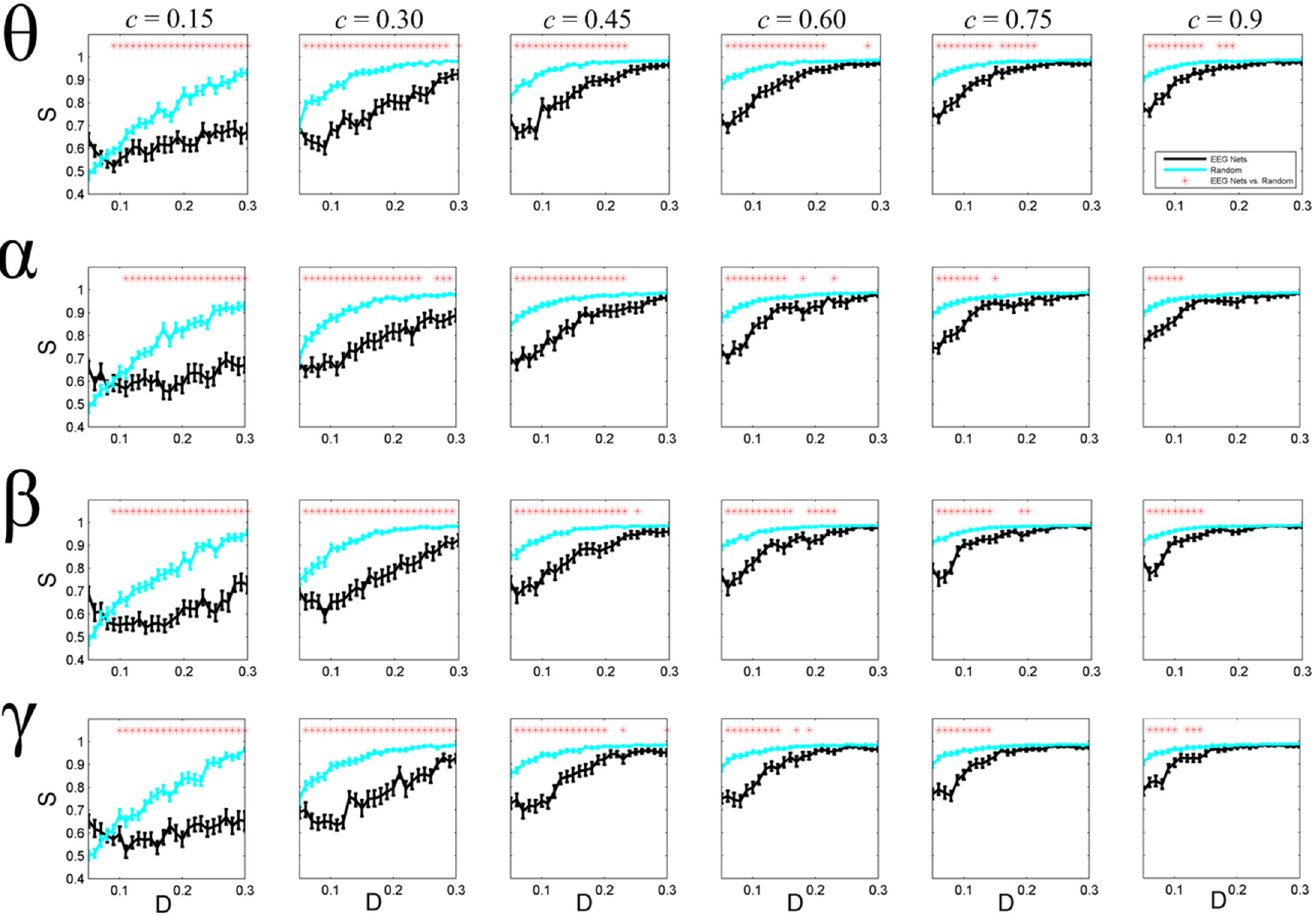
Fig 3. Cascaded failures in EEG-based brain functional networks and the corresponding randomized versions. The graphs show the normalized size of the survived nodes (the mean value with bars indicating the standard error) as a result of a cascaded failure. The graphs are for different values of parameter c (see Eq (6) for details), where higher values of c indicate higher load capacity for the nodes, and consequently, better resiliency against a cascaded failure. The failure starts by removing the node with the highest betweenness centrality value, then redistributing the loads, and then removing the nodes for which the load is higher than the capacity. The process is repeated until no further removal is needed and a steady state solution is obtained. Finally, the percentage of the survived nodes ( S ) is plotted as a function of the network density.